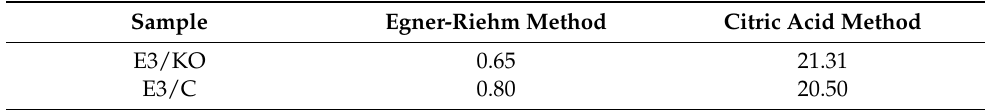
Table 9. Content of bioavailable forms of phosphorus (% wt.) in ash obtained from the combustion of poultry manure in experiment